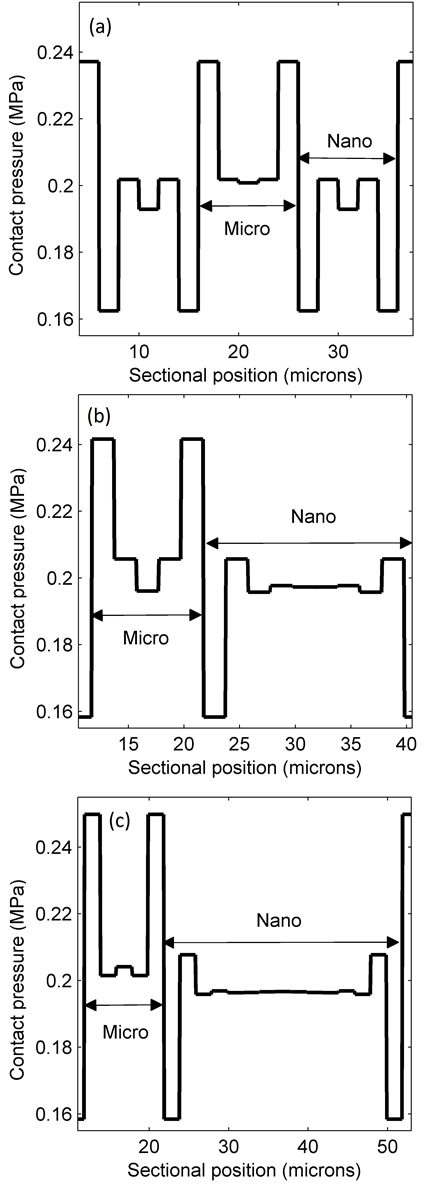
Figure 9. Contact pressure profiles for micro/nano ratios of ( a ) 1:1; ( b ) 1:2; and ( c ) 1:3.